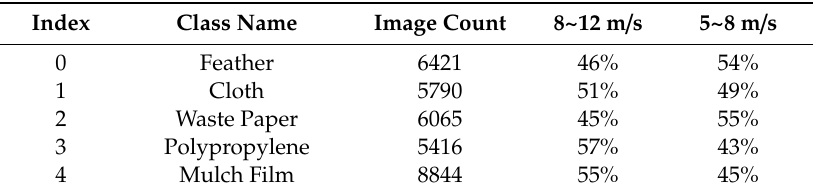
Table 1. Descriptions of the database images.